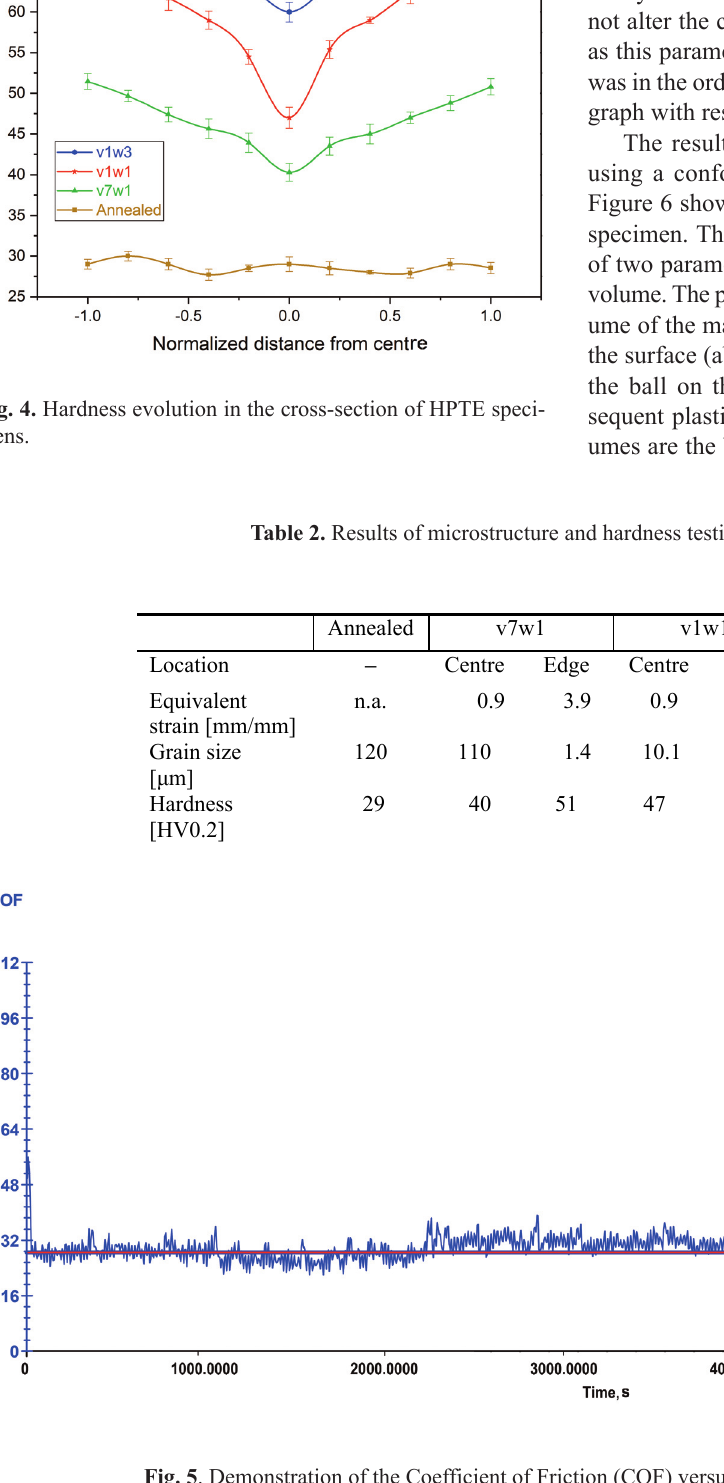
Fig. 5 . Demonstration of the Coefficient of Friction (COF) versus time in the v1w3 specimen.